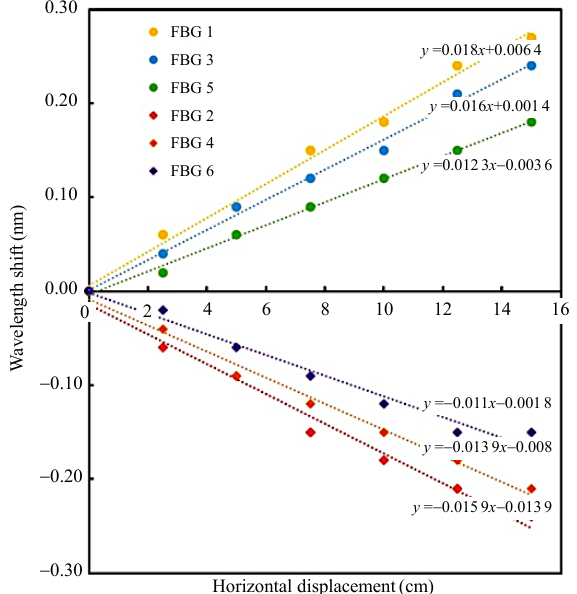
Fig. 7 Wavelength shift (nm) of the FBGs experiencing tensile (FBG 1, FBG 3, and FBG 5) and compressive strain (FBG 2, FBG 4, and FBG 6), in response to increasing horizontal displacement (cm).